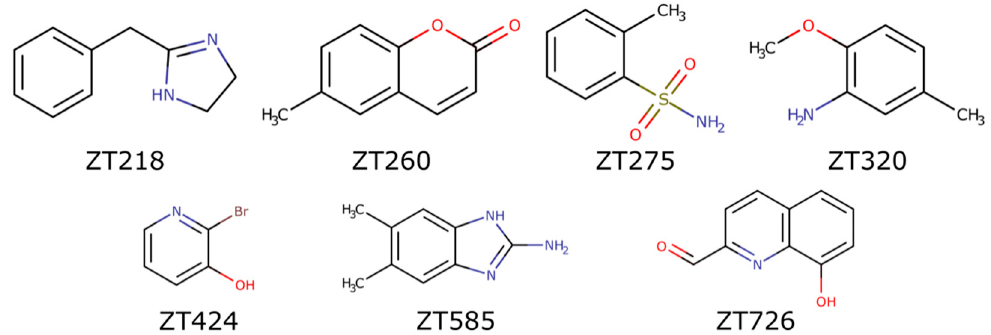
Figure 1. Structures of the fragments bound to Hma. Table 1. Data collection and refinement statistics.